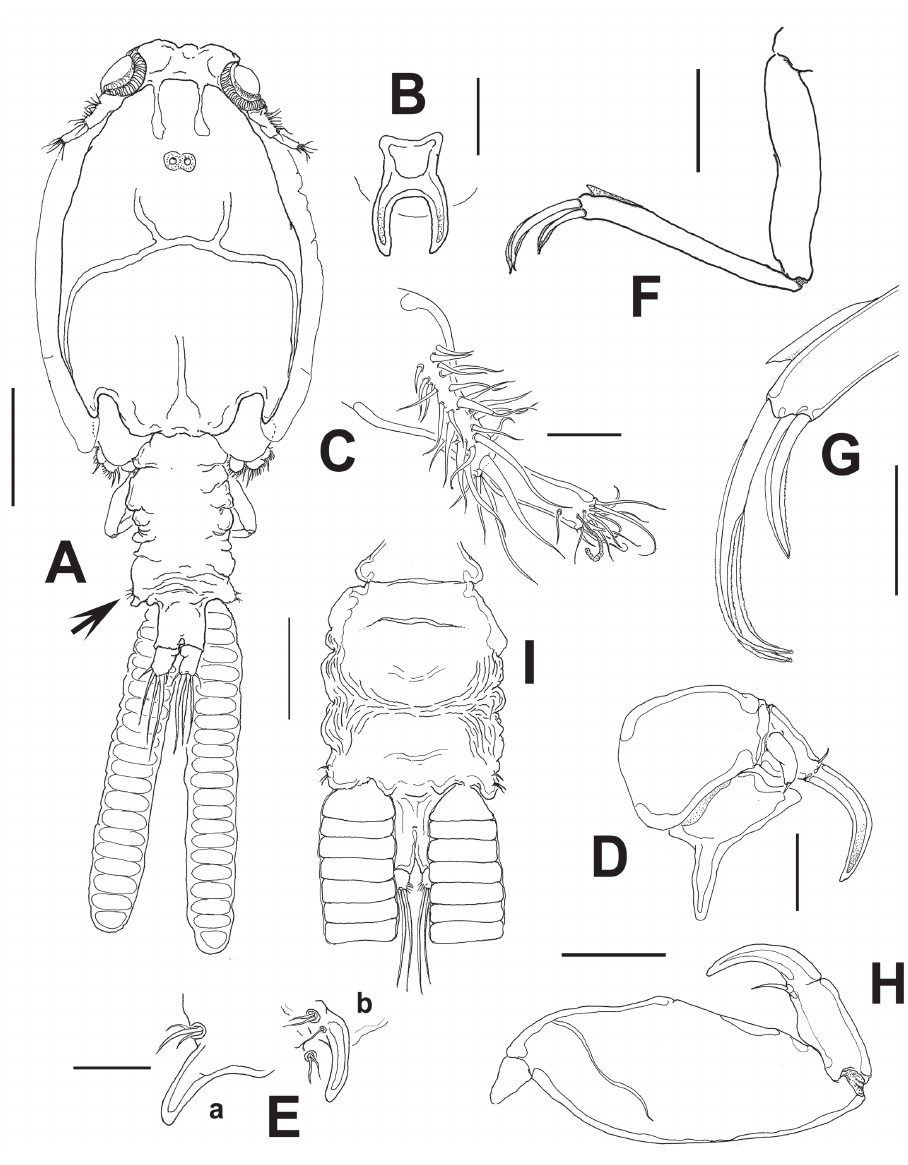
Figure 1. Caligus evelynae sp.n., adult female from Venezuela: A habitus, dorsal view B sternal furca, ventral view C antennule D antenna e postantennal process ( b ) and maxillule ( a ) F maxilla G detail of calamus and canna h maxilliped i genital complex and abdomen, ventral view. Scale bars: A, I =0.5 mm, B–F, H =0.1 mm, G =0.05